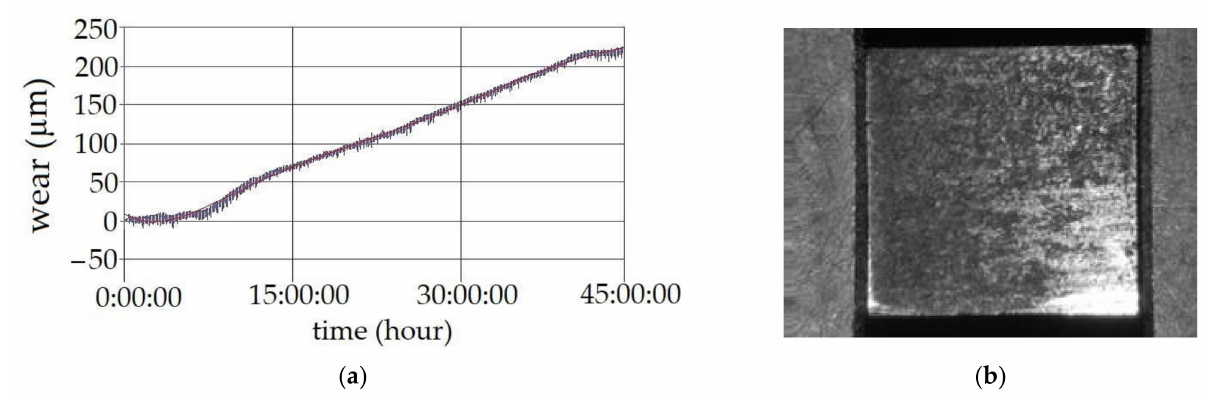
Figure 11. ( a ) The time dependence of the wear size of the testing specimen of the base material. ( b ) The macrostructure of the friction surface of the testing specimen after the tribological